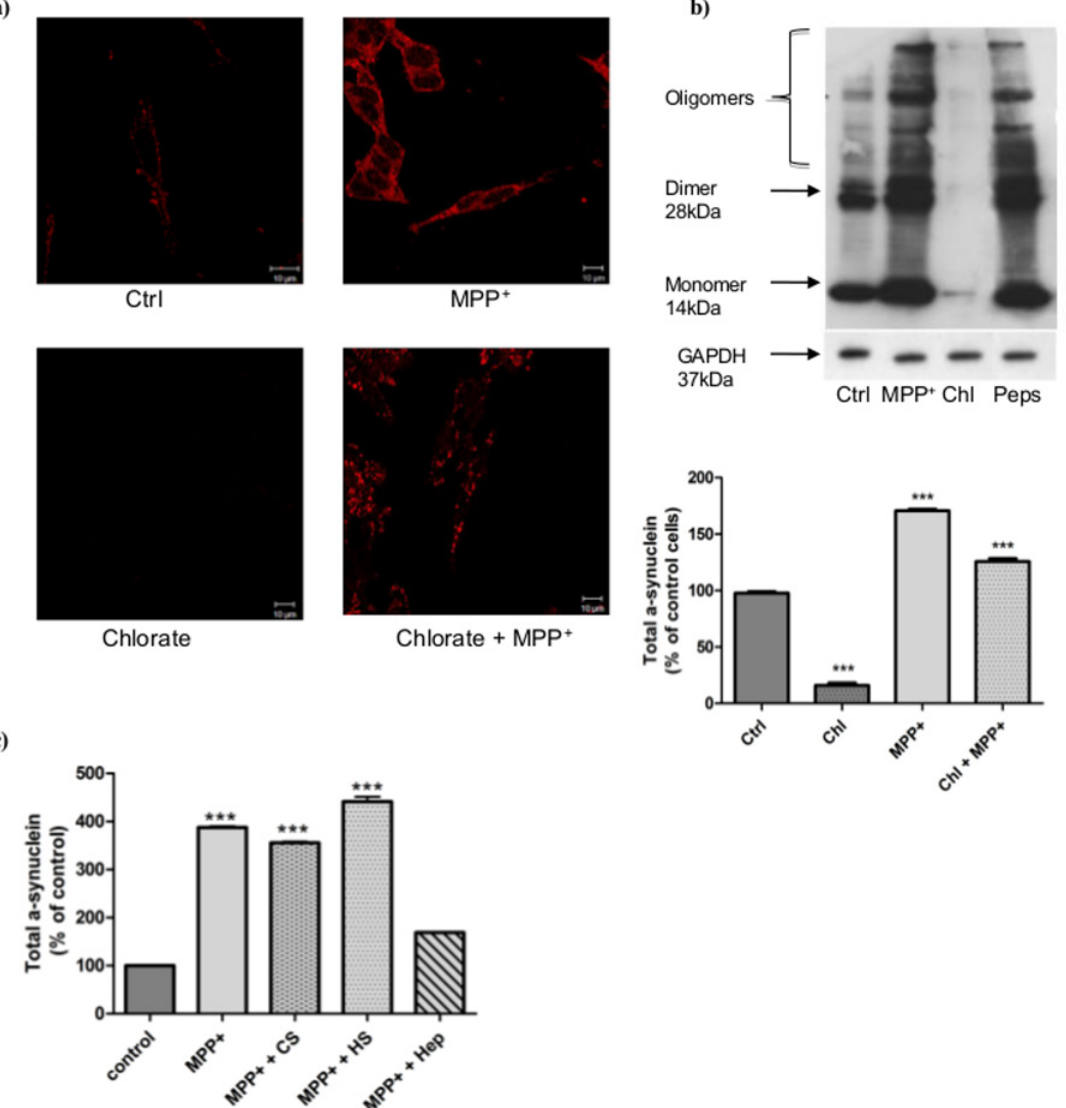
Figure 6. Effect of glycosaminoglycans sulfation on α -synuclein accumulation. a) Total α -synuclein accumulation was detected after 6 h in normal (Ctrl) or MPP + -treated cells and after chlorate treatment (75 mM, 24h). α -synuclein aggregation was visualized by immunostaining. Cells were observed with a confocal microscope Zeiss Axio Observer Z.1. b) Western blot analysis of total α -synuclein in lysate of cells subjected or not to MPP + stress (6 h) after treatment with sodium chlorate (75 mM, 24h) or the specific inhibitor of cathD, pepstatin A (Peps) (100 μ M, 24h). Intensities of the bands obtained by western blot were quantified by ImageJ software and represent three independent experiments and are expressed as the mean ± S.E.M. *** p < 0.001 compared to control cells. GAPDH was used as the loading control. c) Amounts of total α -synuclein in cells subjected or not to MPP + stress (6 h) and followed by commercial GAGs treatment (Hep, HS and CS, 1 μ g/mL). After 24 h, α -synuclein was detected by western blot and quantified with ImageJ